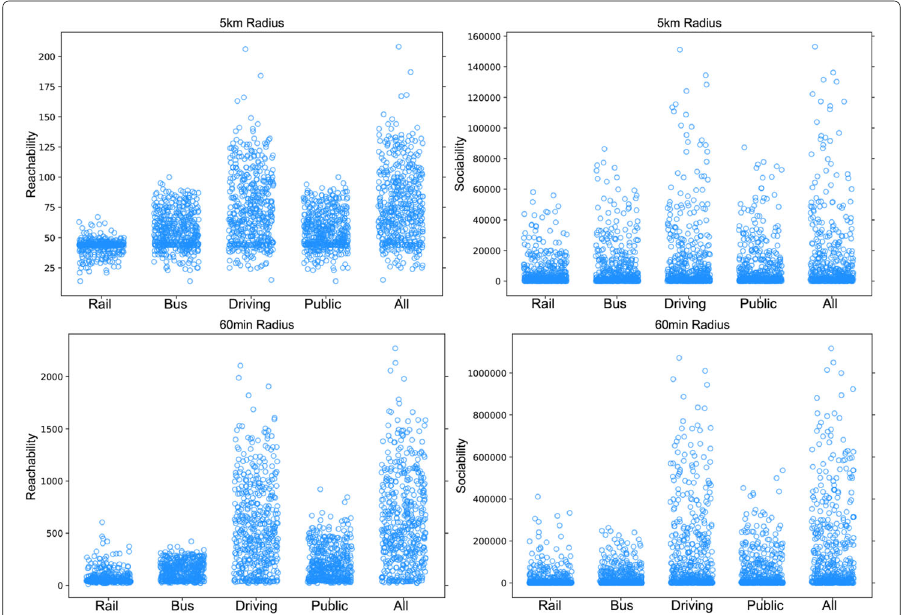
Fig. 10 Reachability and sociability scores for each location broken down by travel pattern for the 5 km and 60m subnetworks. The patterns reveal similarities and differences between these geotemporal measures as well as demonstrate the role of synergy and the overall dominance of the road network discussed in detail